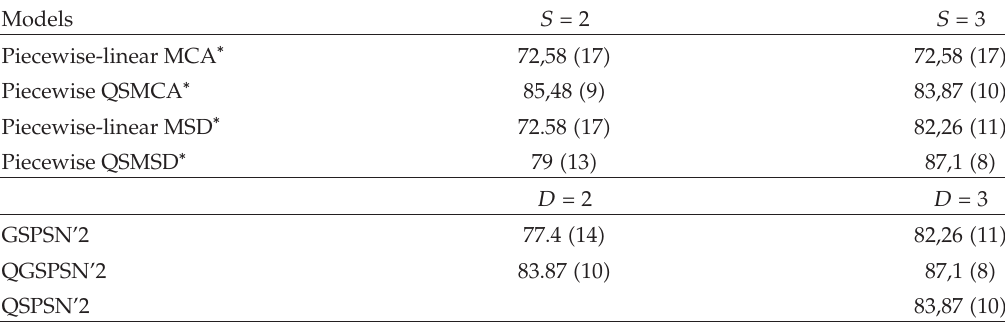
Table 9: Classification rates using the LOO procedure (cid:2) in percentage (cid:3)